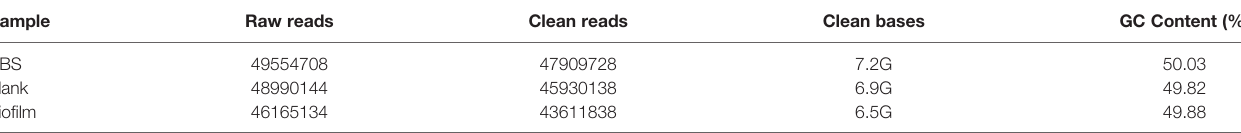
TABLE 2 | RNA-seq data